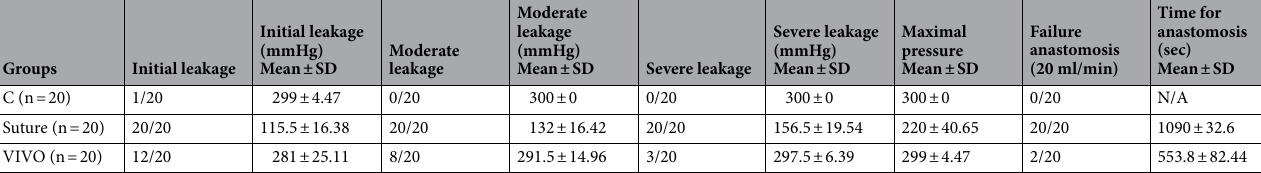
Table 2. Results of burst pressure test.